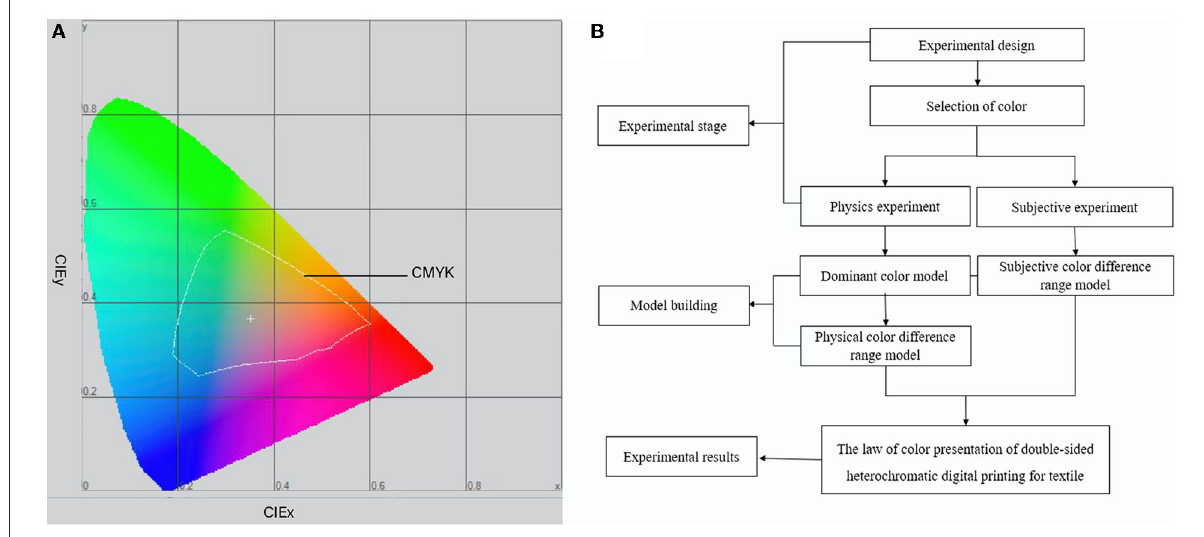
FIGURE1 (A) Color gamut range of ICC profiles. (B) Experimental flow